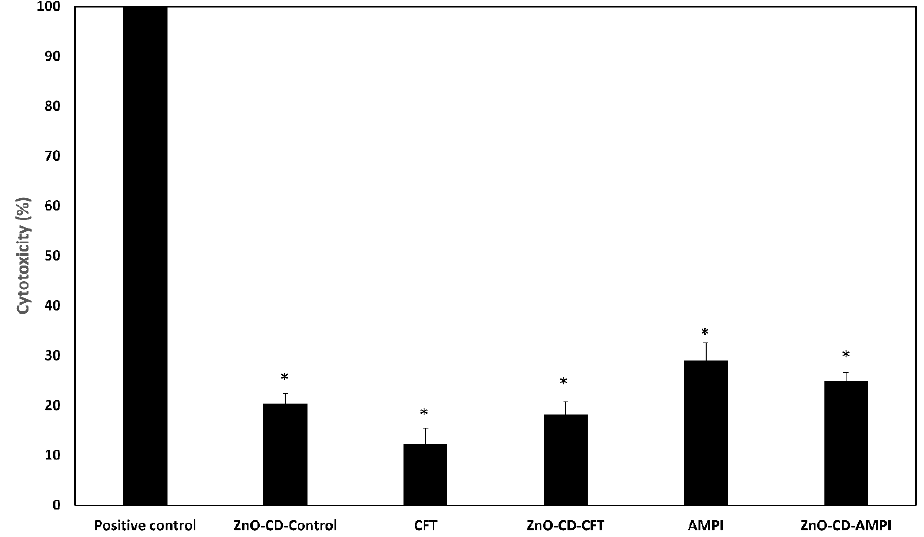
Figure 7. Cytotoxicity assays were performed to determine the toxicity of these compounds towards human cells. All the employed compounds displayed minimal cytotoxicity. The results presented as the mean ± standard error (* is p <